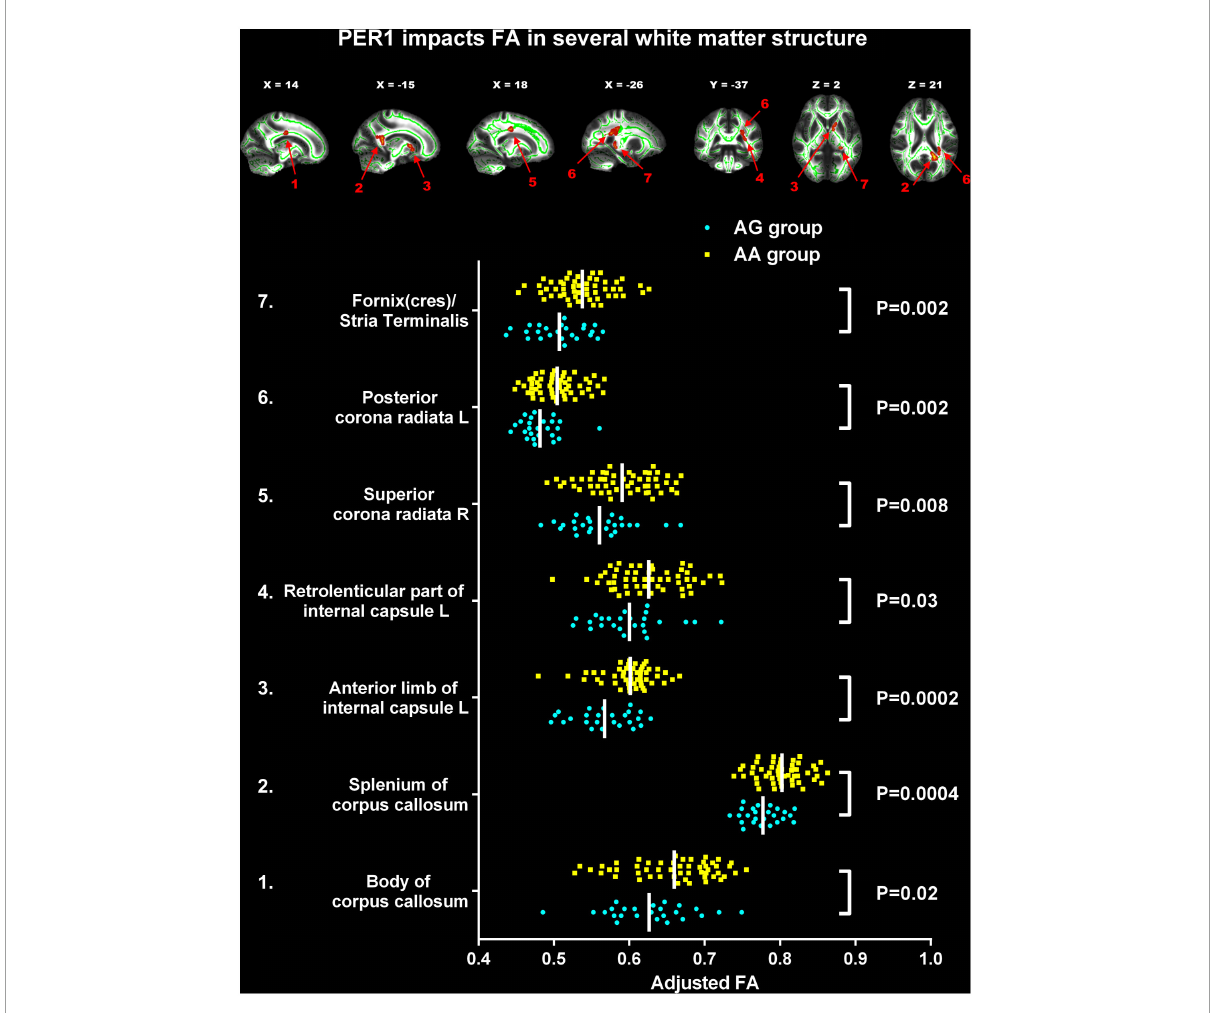
FIGURE1 Significant changes of fractional anisotropy (FA) between two PER1 genotypes. The significant difference was observed in the following seven white matter tracts between G carrier group and AA group: 1. Body of corpus callosum (CC); 2. Splenium of CC; 3. The left anterior limb of internal capsule; 4. The left retrolenticular part of internal capsule; 5. The right superior corona radiata; 6. The left posterior corona radiata; 7. Left fornix(cres)/strial terminalis. FA, fractional anisotropy; L, left; R, right. The yellow box represents AA group; the blue dot represents the AG